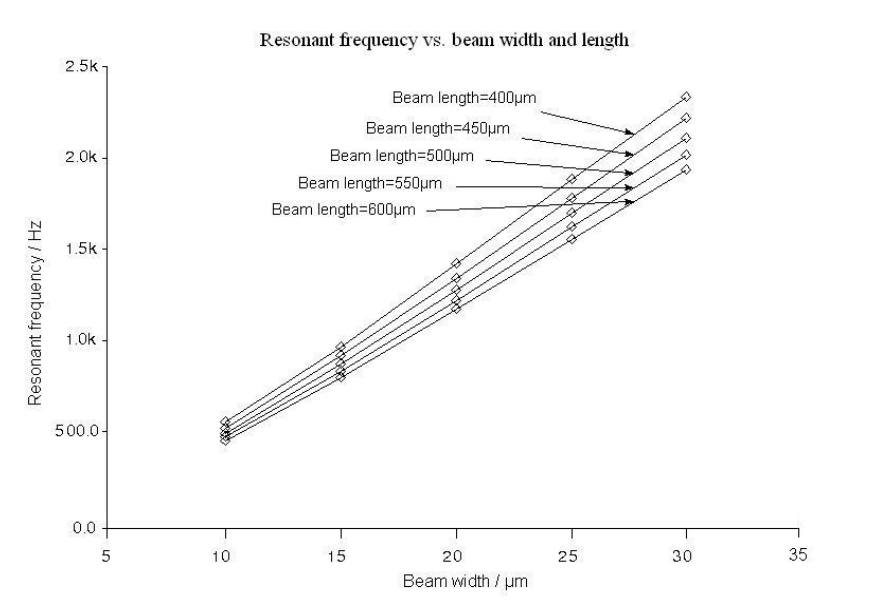
Figure 11. Resonant frequency over beam width and